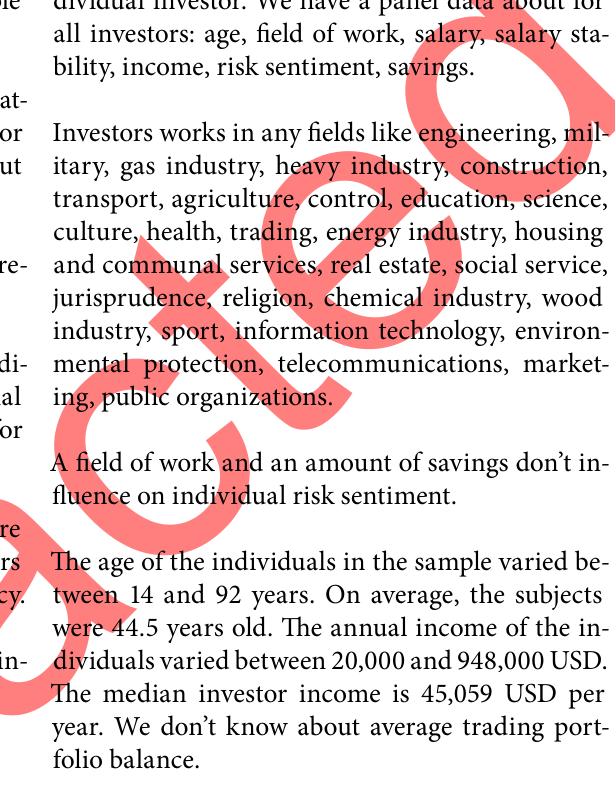
Table 2. The share of each answer of individual investors in Russia Source: Authors’ calculation. Very Risk- High risk Normal risk high Question averse sentiment sentiment